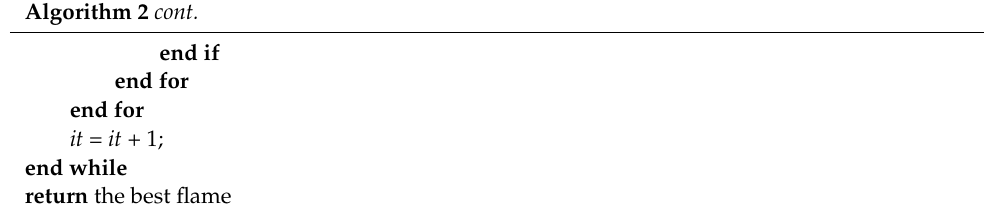
Algorithm 2 cont.